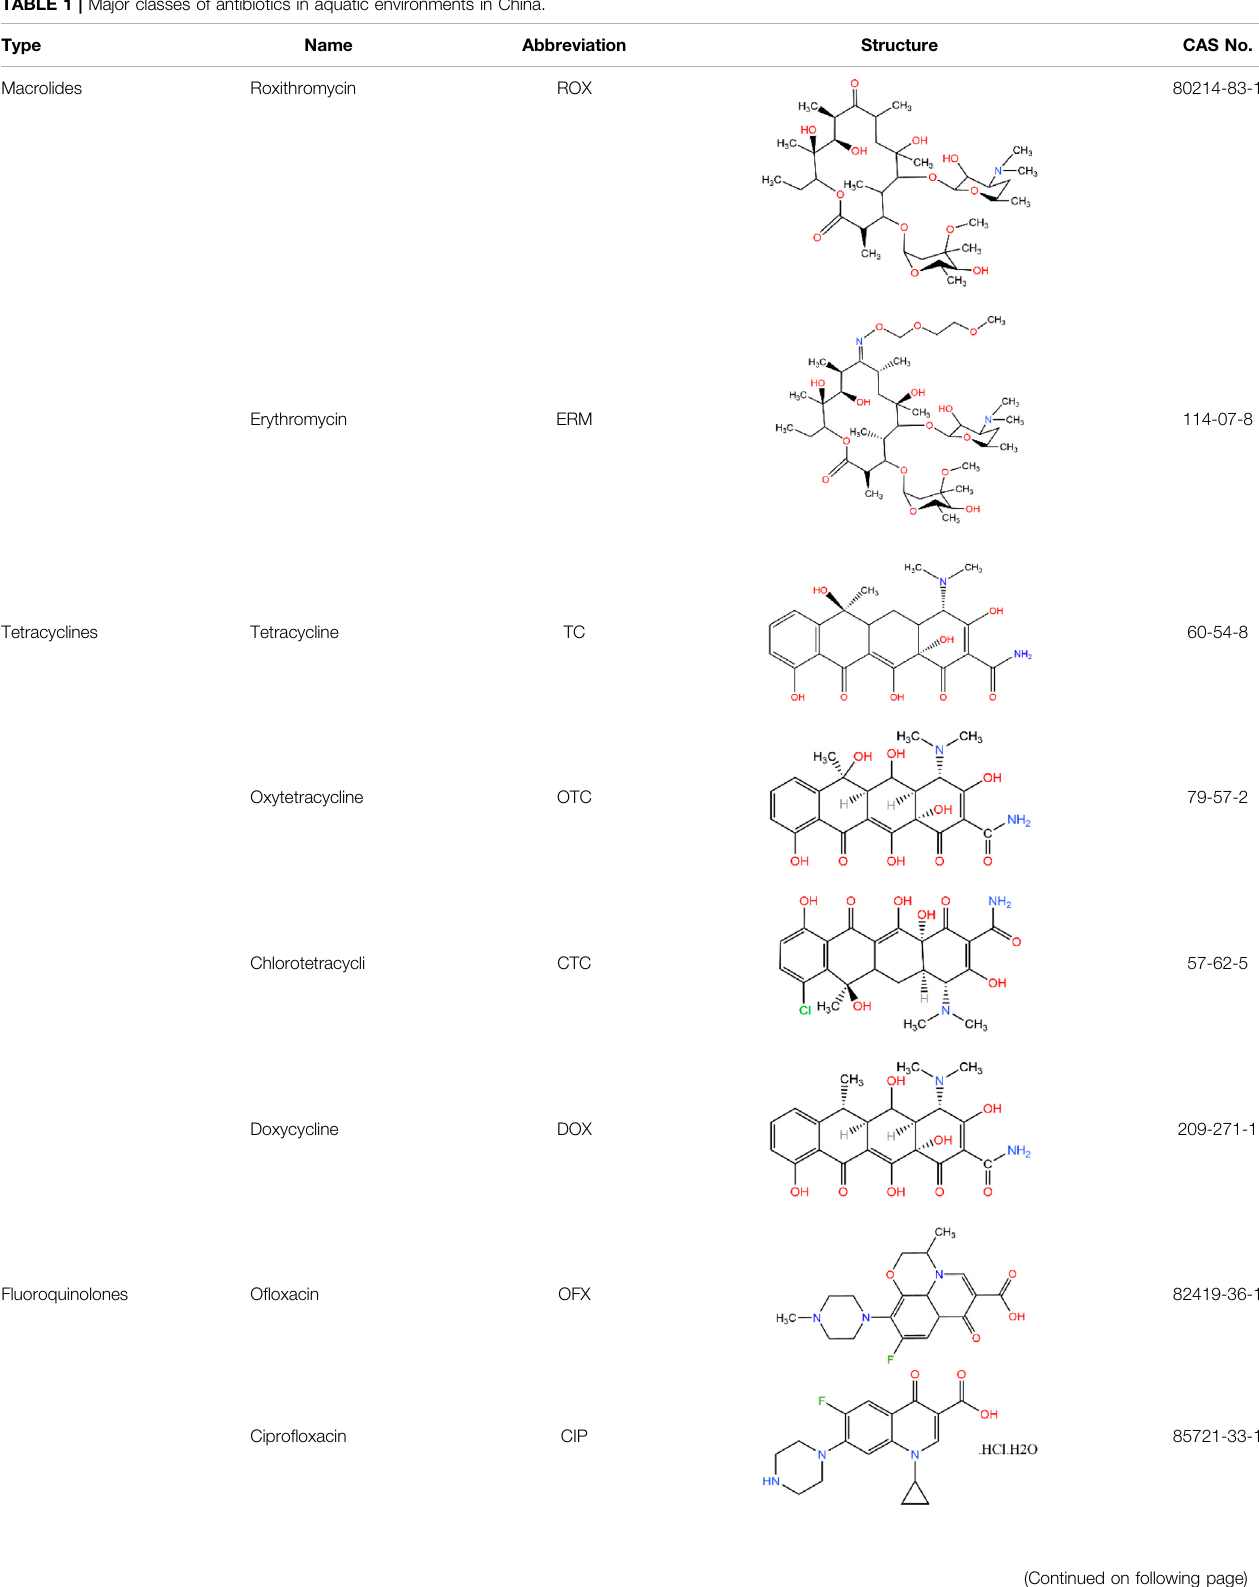
TABLE 1 | Major classes of antibiotics in aquatic environments in